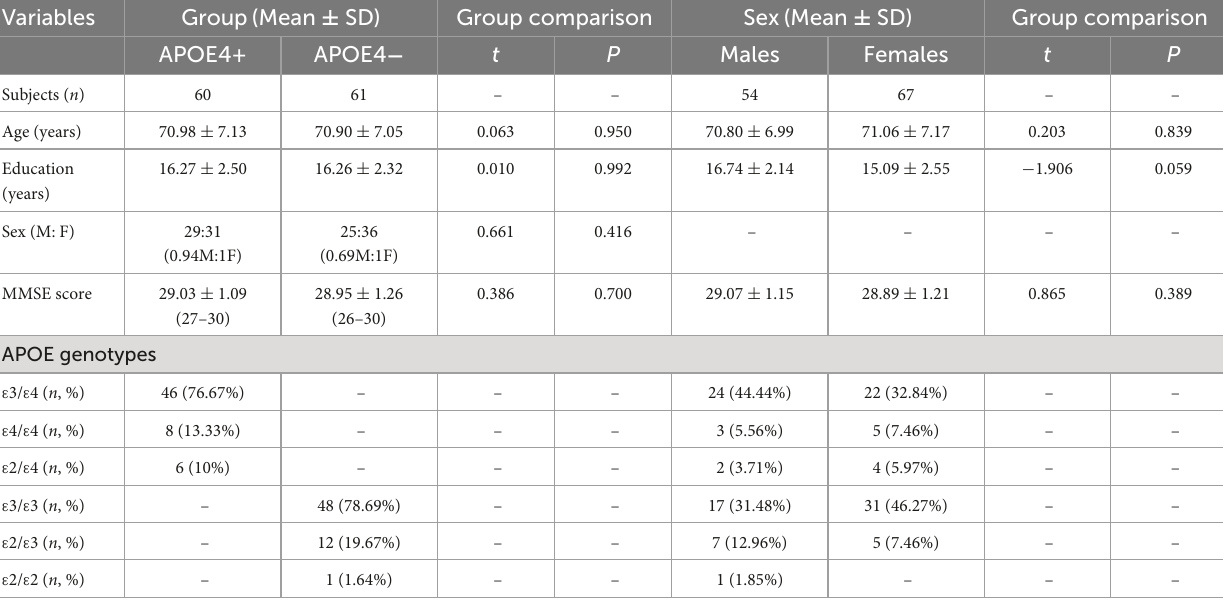
TABLE 1 Summary of participants’ demographics and Mini-Mental State Examination scores (MMSE) for APOE4 carriers (APOE4+) and non-carriers (APOE4 − ) and for males and females. Variables